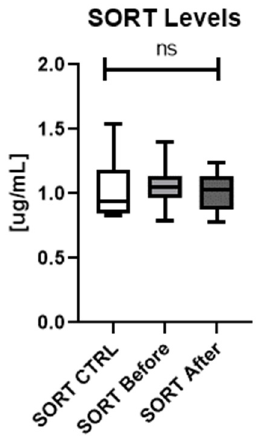
Figure 5. Concentrations of SORT in patients (before and after the treatment) and controls. There was a negative correlation between SORT and PASI (R = − 0.48) and a positive between SORT and BMI (R = 0.44) (Figure 2).